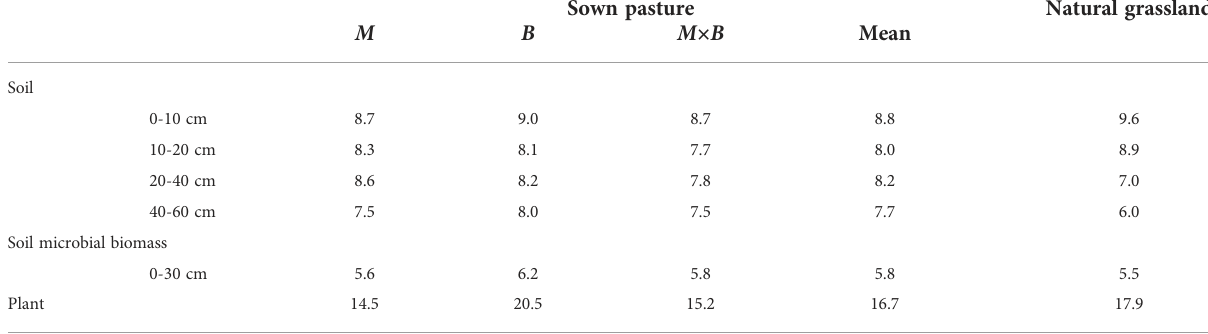
TABLE 5 C:N ratios of the mineral soil, the soil microbial biomass and the plants of alfalfa (M), smooth bromegrass (B), M×B mixture and the natural grassland. Sown pasture Natural grassland M